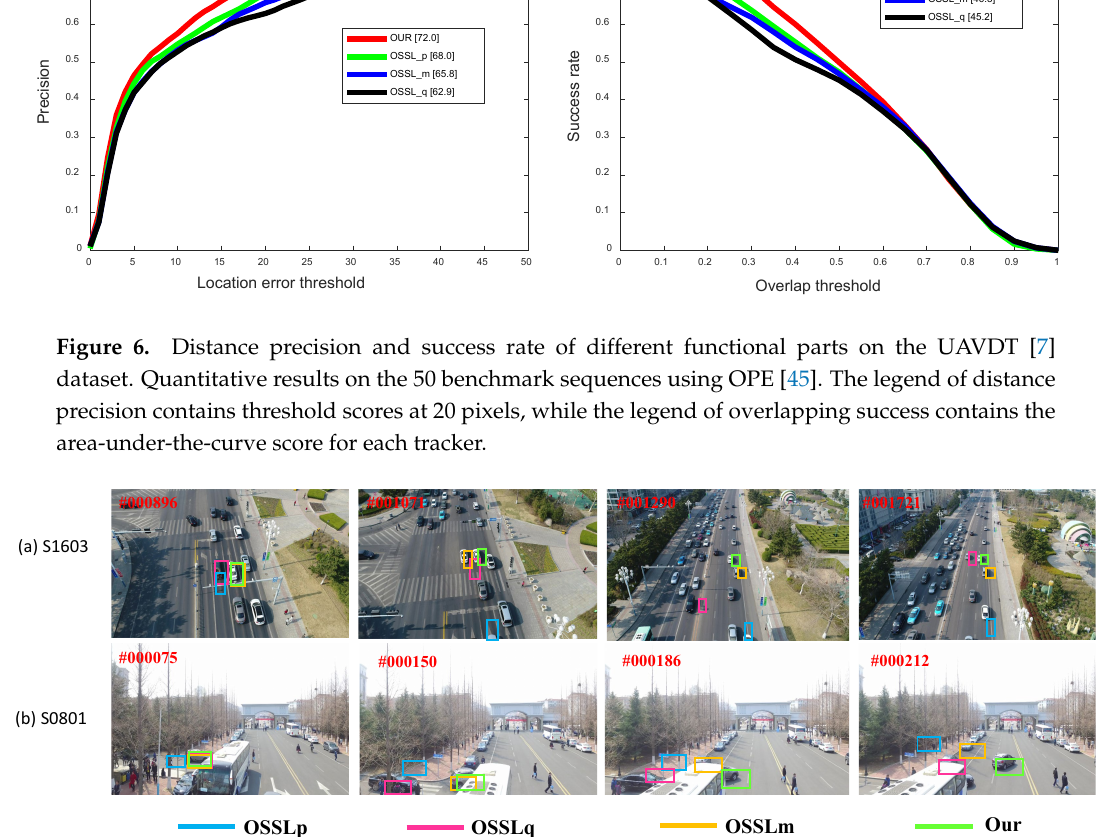
Figure 7. Quantitative analysis results of ablation analysis on challenging image sequences ( S1603 and S0801